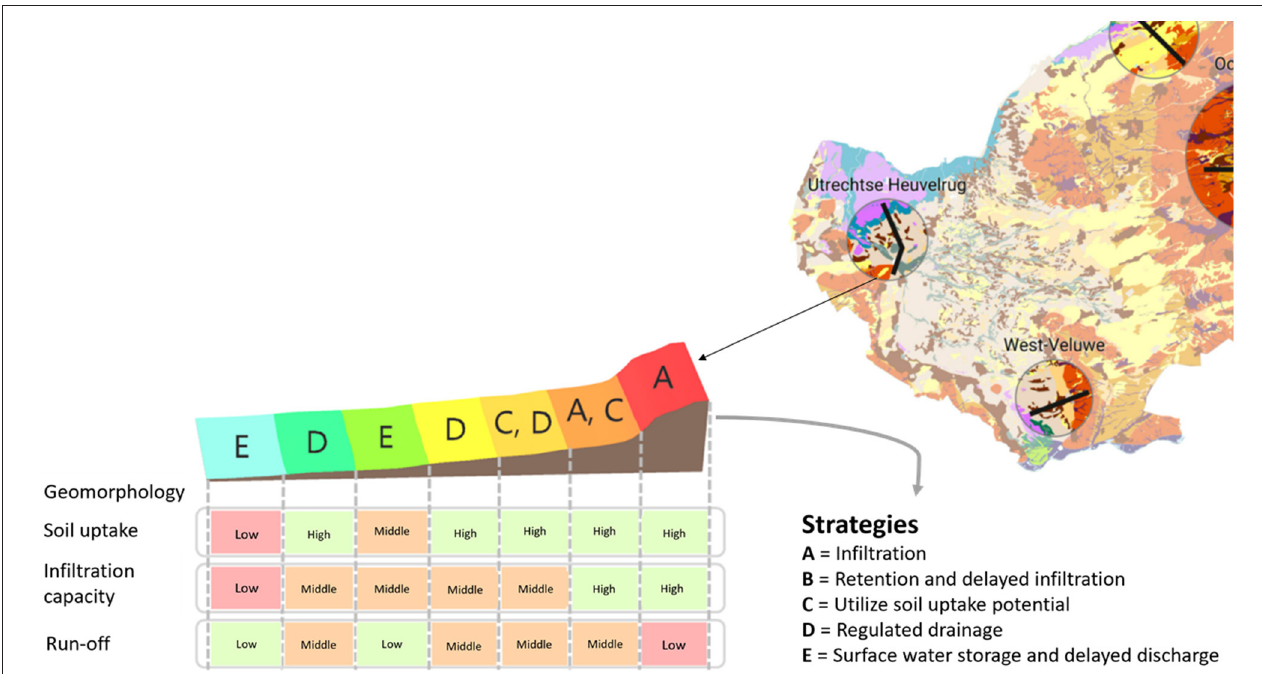
FIGURE 1 | Klimaateffect Vallei en Veluwe